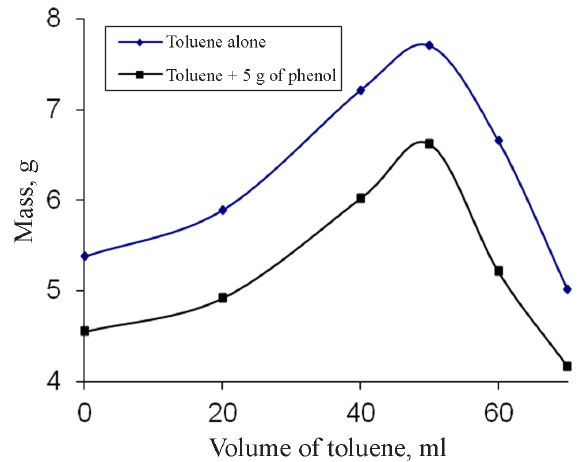
Fig. 3. Variation of the insoluble material in CHCl